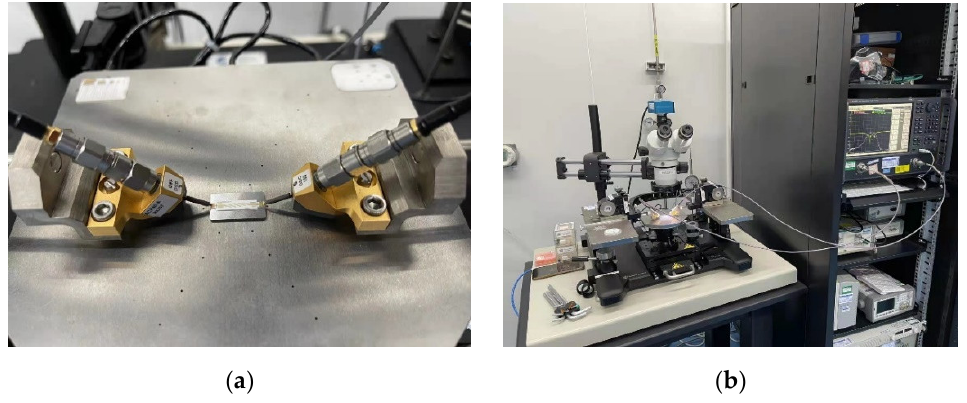
Figure 7. The picture of: ( a ) probe operation table; ( b ) measured system.